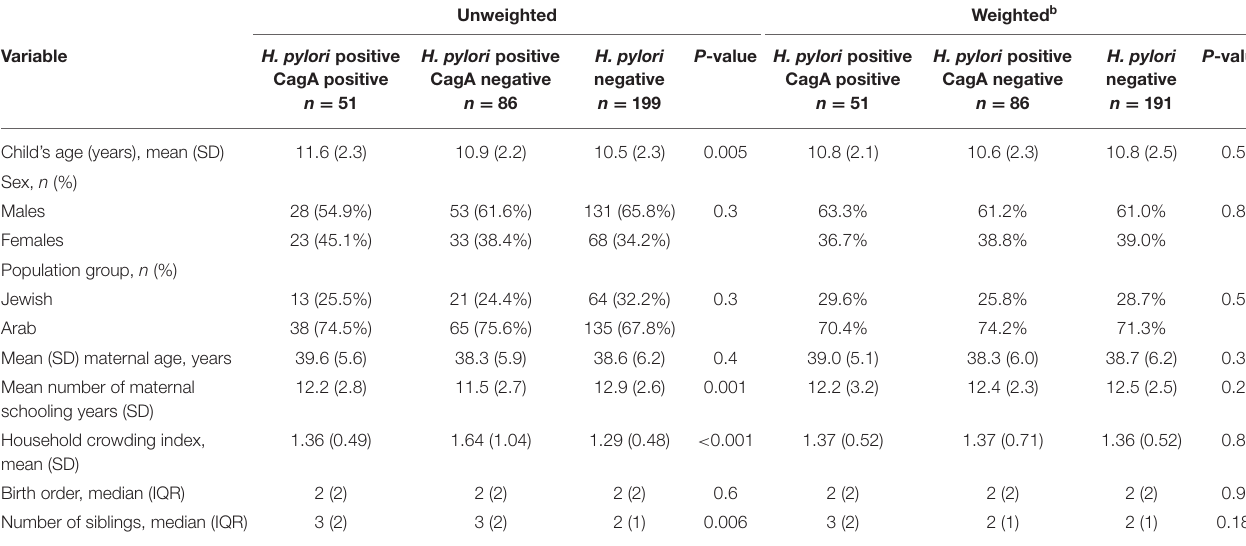
TABLE 1 | The association between sociodemographic variables and H. pylori /CagA IgG seropositivity a .